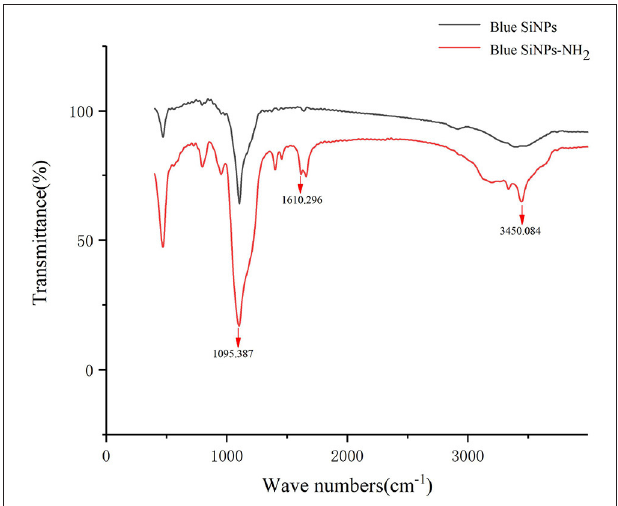
FIGURE 1 | FT-IR spectra of blue SiNPs (top) and blue SiNP-NH 2 (bottom). was run with three parallel tests. iELISA was run according to the previous protocol.